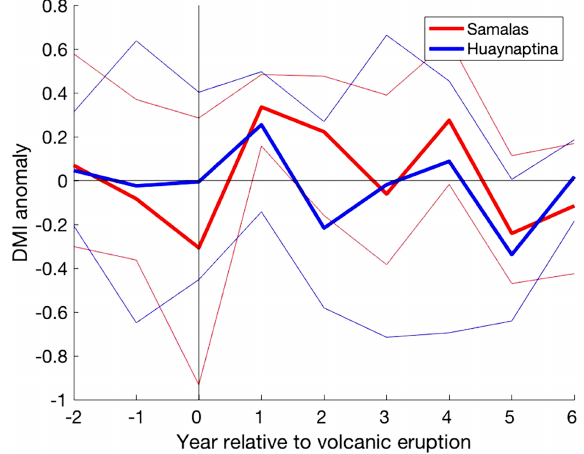
Figure 5. Mean DMI response of all volcanic ensembles (four CR ensembles and one 2 × G ensemble) to the largest (1258 Samalas) and smallest (1600 Huaynaputina) eruptions analysed over JASON. The bold lines represent the mean of all volcanic ensembles to each eruption, and the fainter lines represent the 90th and 10th percentile of the ensemble members.